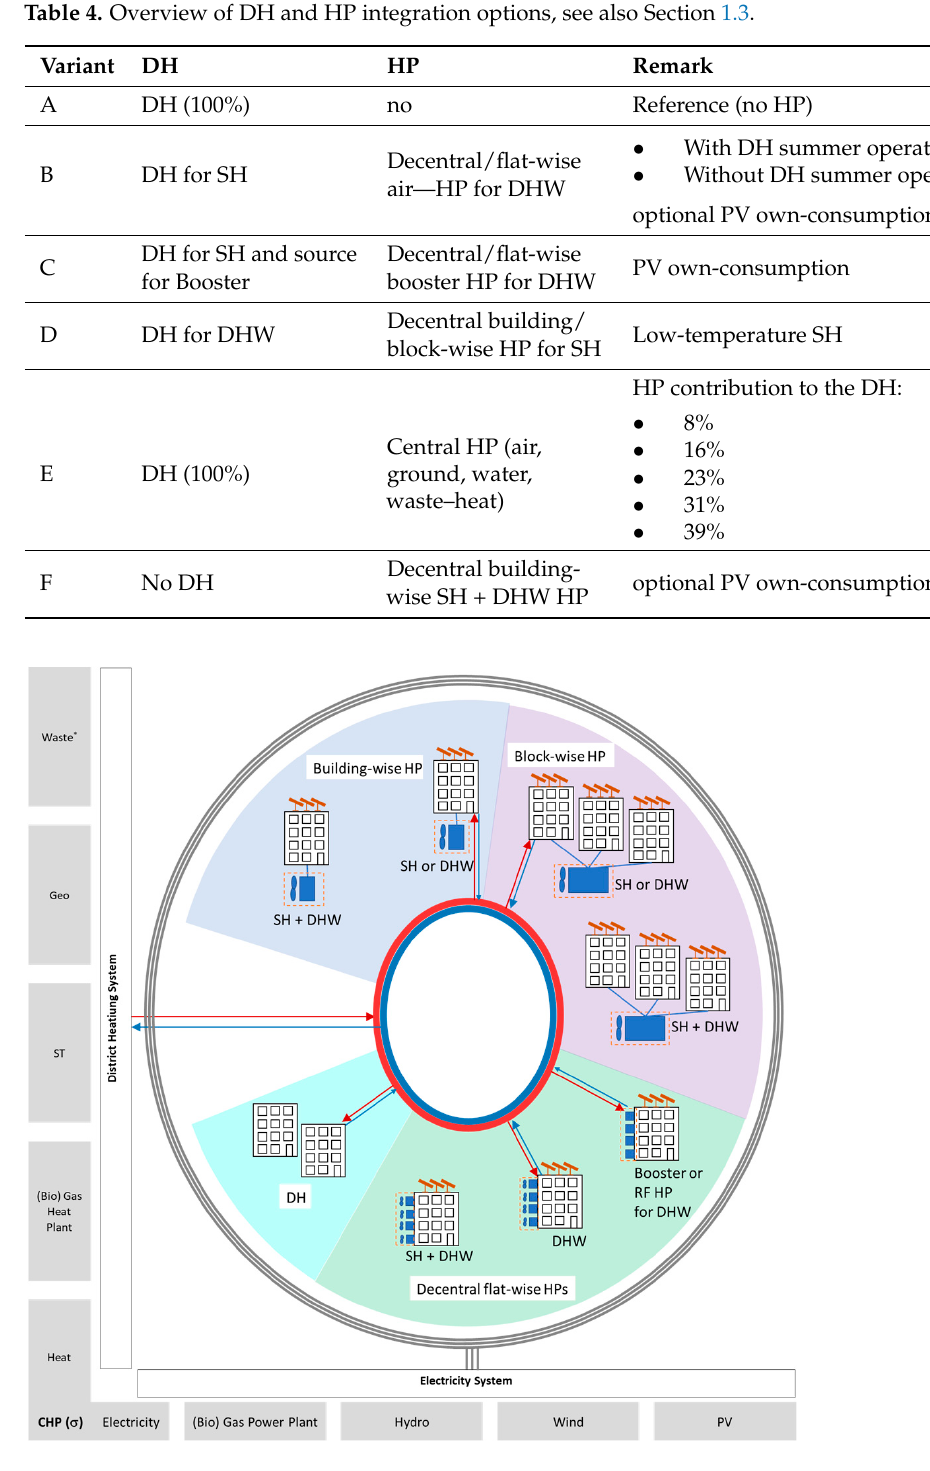
Figure 8. Sketch of the interactions between electric system, DH and load (i.e., Buildings) (i.e., SH: Space Heating, DHW: Domestic Hot Water, RF: Return Flow, HP: Heat Pump, DH: District Heating) * industrial waste heat and incineration.